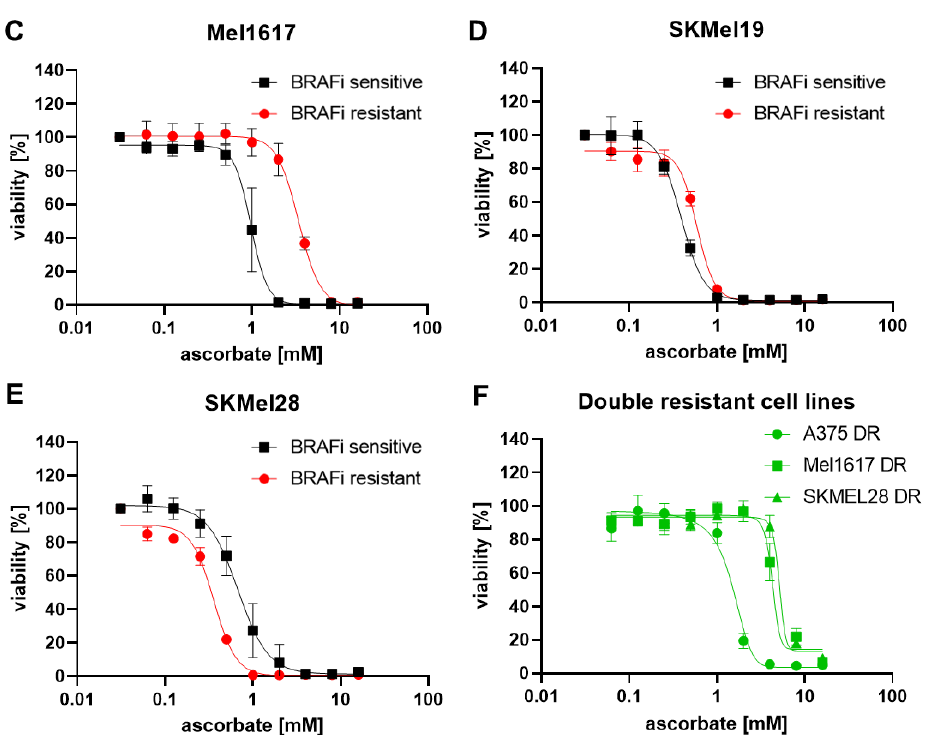
Figure 2. Growth inhibitory effects of ascorbate on melanoma cells.: ( A – E ) 451Lu ( A ), A375 ( B ), Mel1617 ( C ), SKMel19 ( D ), SKMel28 ( E ) and double-resistant/DR ( F ) melanoma cell lines were treated with different concentrations of ascorbate. The viability of treated cells was measured by the MUH assay and compared to the untreated control. The BRAFi sensitive cell lines are shown in black and the BRAFi resistant cell lines are shown in red. Shown are the mean values with standard deviations of three independent experiments, each measured in hexaplicates and normalized to the untreated control.